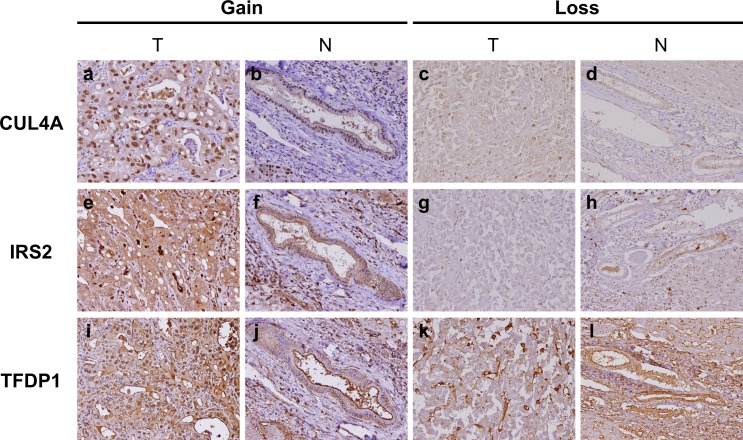
Immunohistochemical analysis in tumors (T) of intrahepatic cholangiocarcinoma and normal bile ductules (N) of the adjacent portal tracts.Positive nuclear staining was observed for CUL 4A and TFDP1, and cytoplasmic staining for IRS2 in tumor cells with amplification of target genes (a, e, i), compared with normal bile ductules in the adjacent portal tracts (b, f, j). Loss of expression for CUL 4A, IRS2, and TFDP1 (c, g, k) was observed in tumor cells containing a deletion of target genes, in contrast to their normal counterparts (d, h, l). Original magnification: × 200.